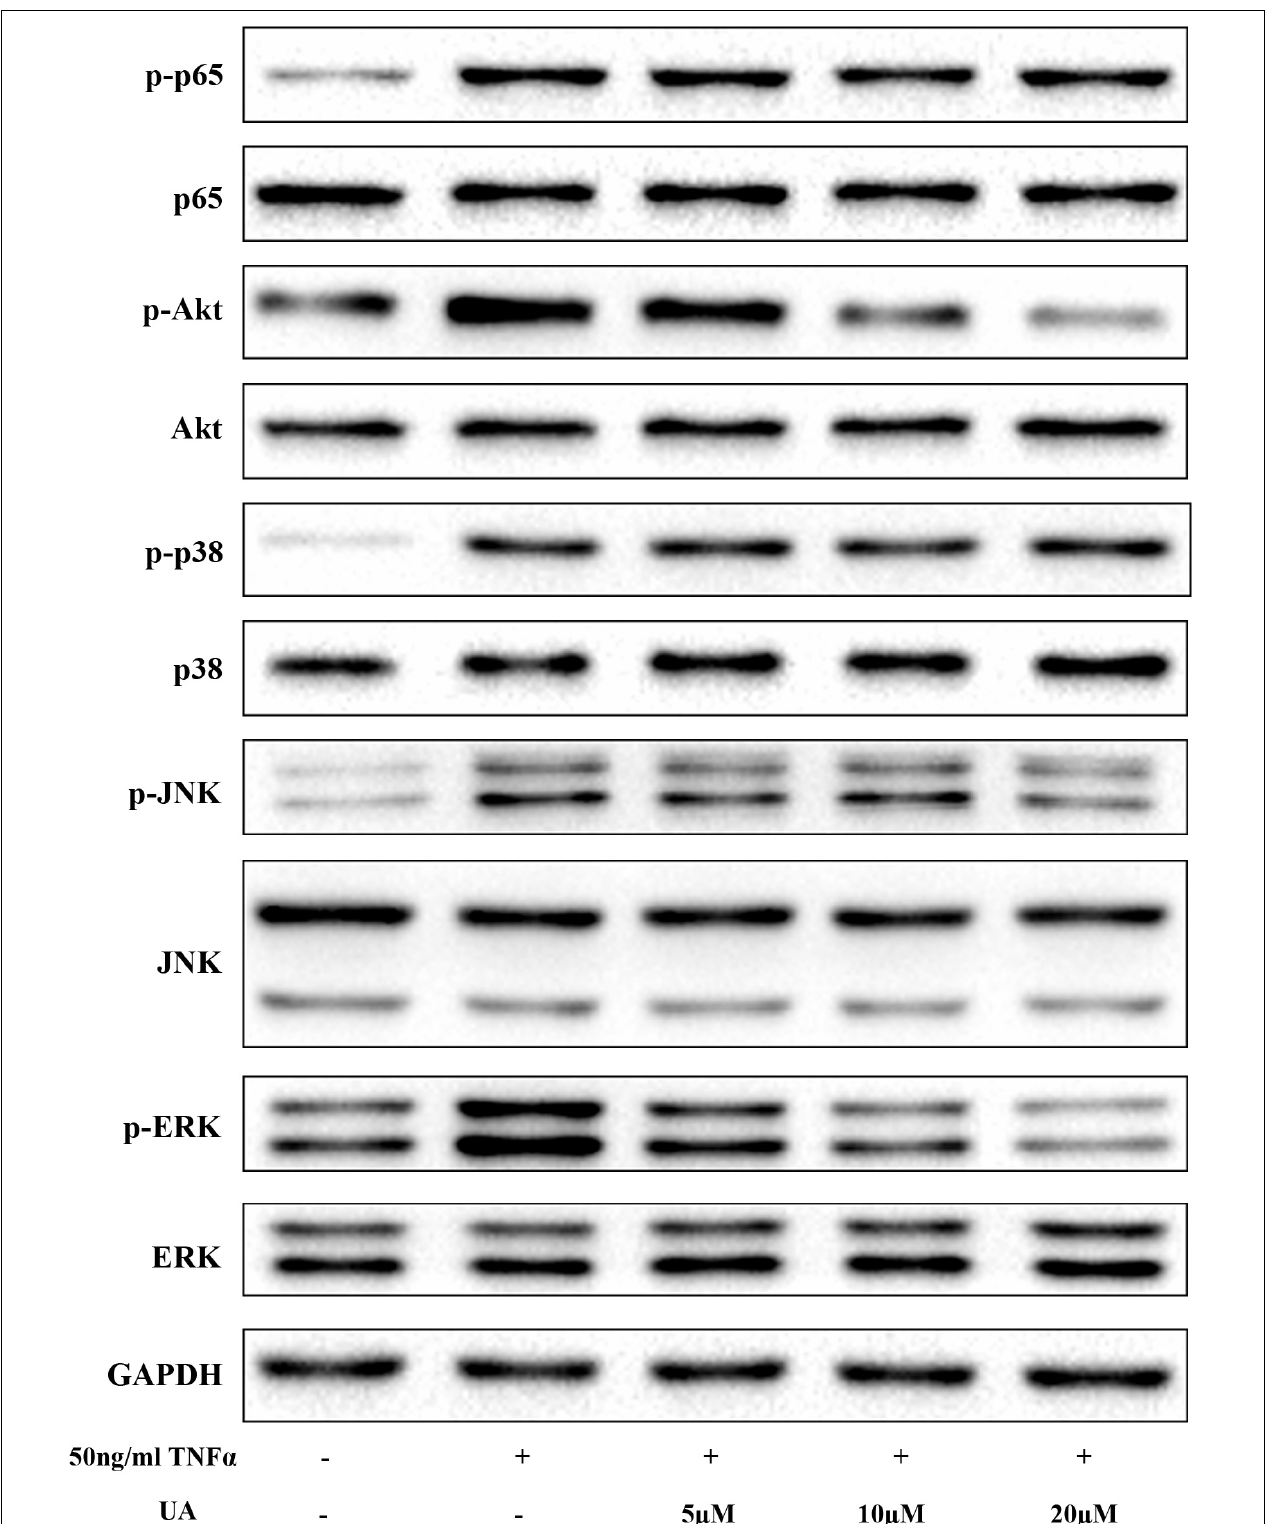
FIGURE 3 | The suppressive effect of UA on the TNF α -induced MAPK and PI3K/Akt pathways. The NP cells were pretreated with the indicated concentration of UA for 2 h. Subsequently, 50 ng/ml of TNF α was added, and the cells were incubated for 30 min. The total protein was then extracted.